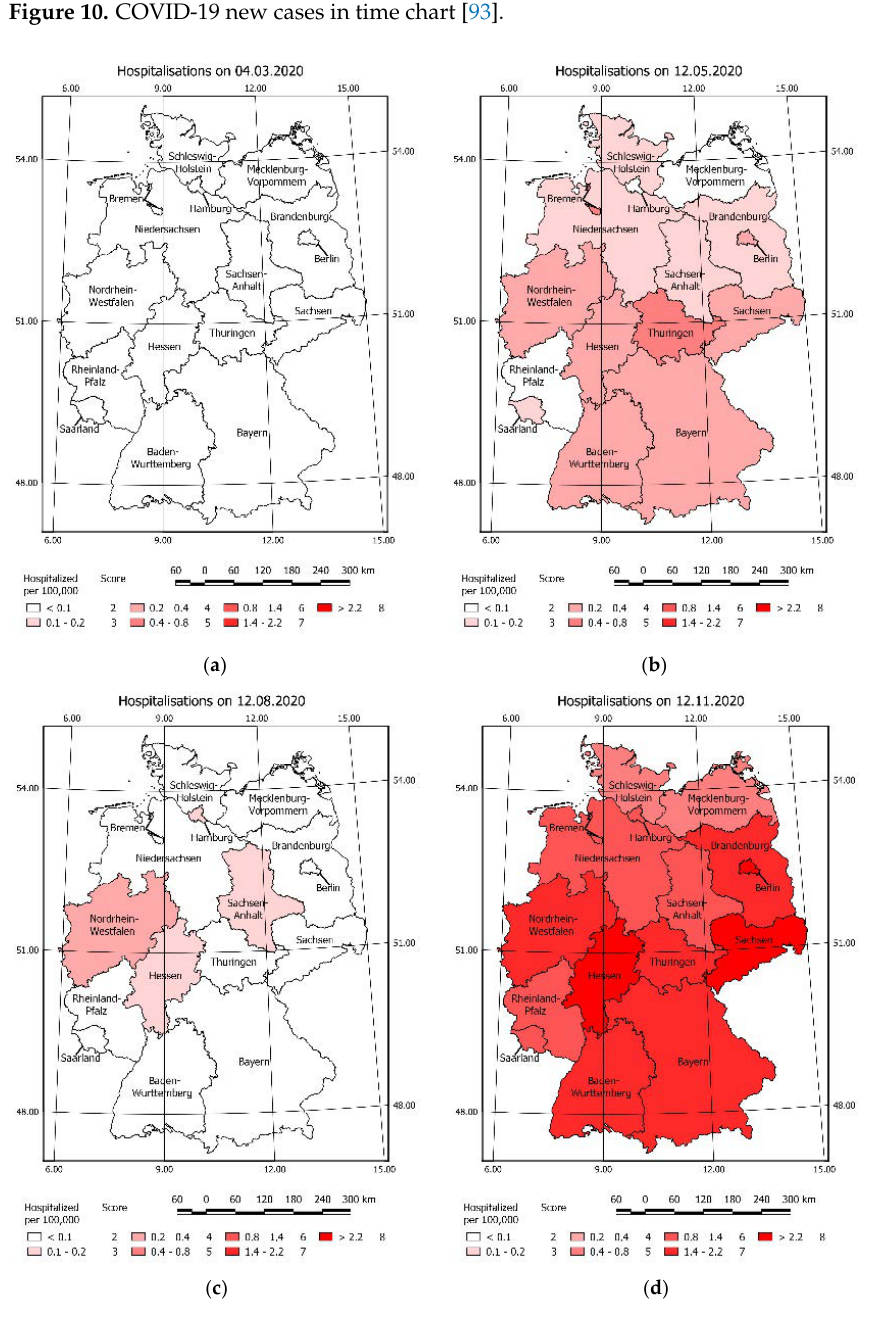
Figure 11. COVID-19 Hospitalisations on selected days: ( a ) 04 March 2020 ( b ) 12 May 2020 ( c ) 12 August 2020 ( d ) 12 November 2020 remaining maps available in APENDIX B2.